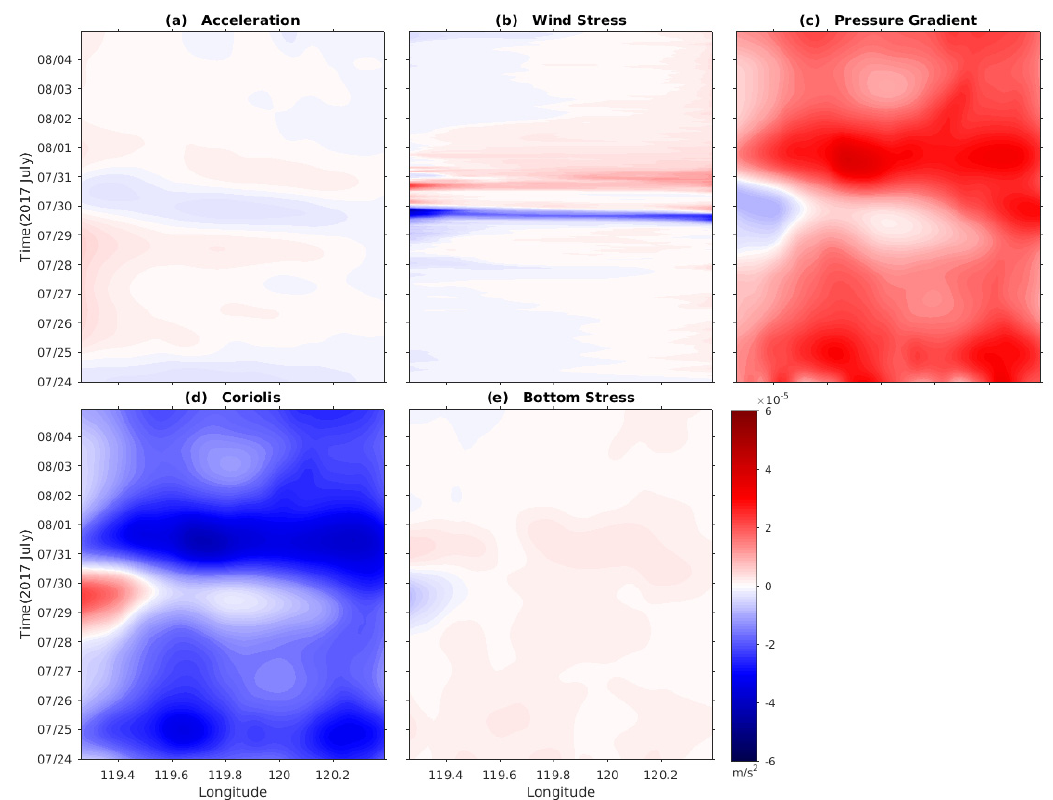
Figure 13. Diagrams of hourly ROMS output of the depth-averaged cross-shore momentum balance terms (Equation (5)) extracted from the cross-shore section shown in Figure 9f. Extracted variables include ( a ) acceleration, ( b ) wind stress, ( c ) pressure gradient, ( d ) Coriolis, and ( e ) bottom stress. Positive is in the onshore directions.